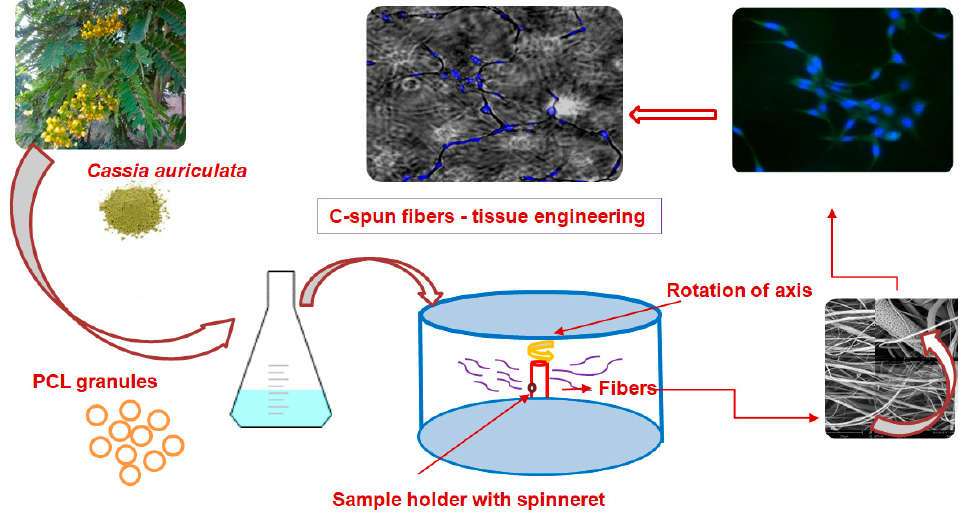
Figure 1. Complete flowchart of the production of fibers through centrifugal spinning.